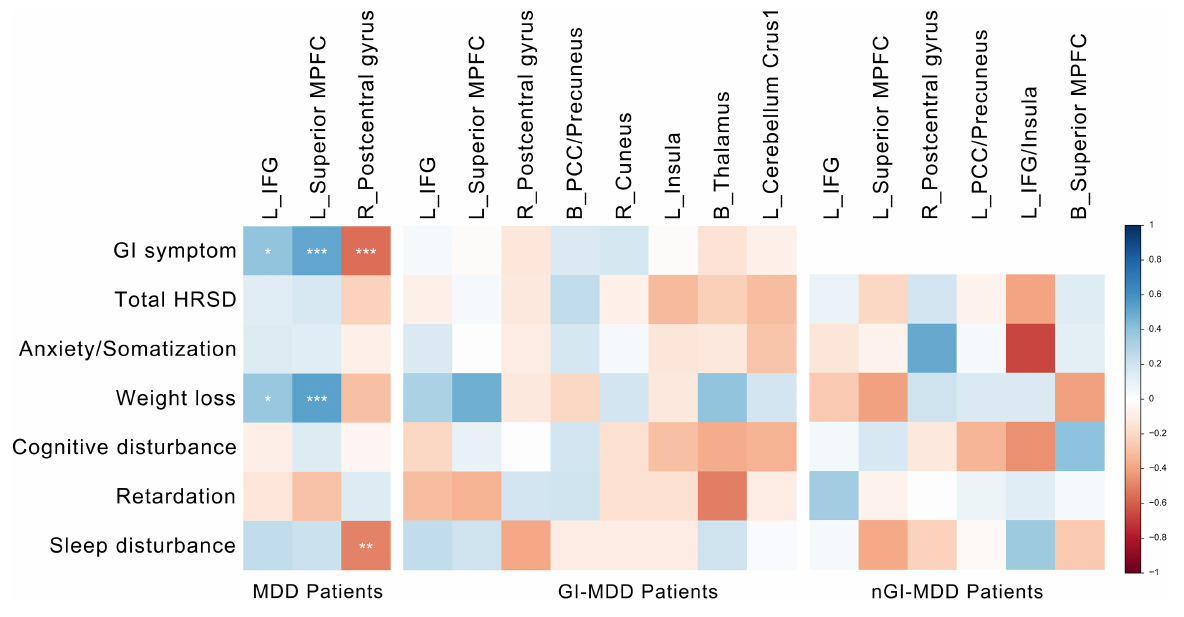
Frontiers in Neuroscience |